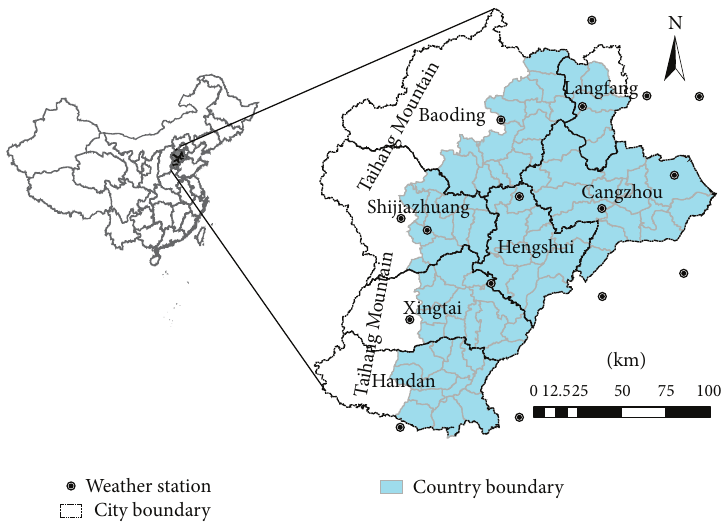
Figure 1: Study area and location of meteorology